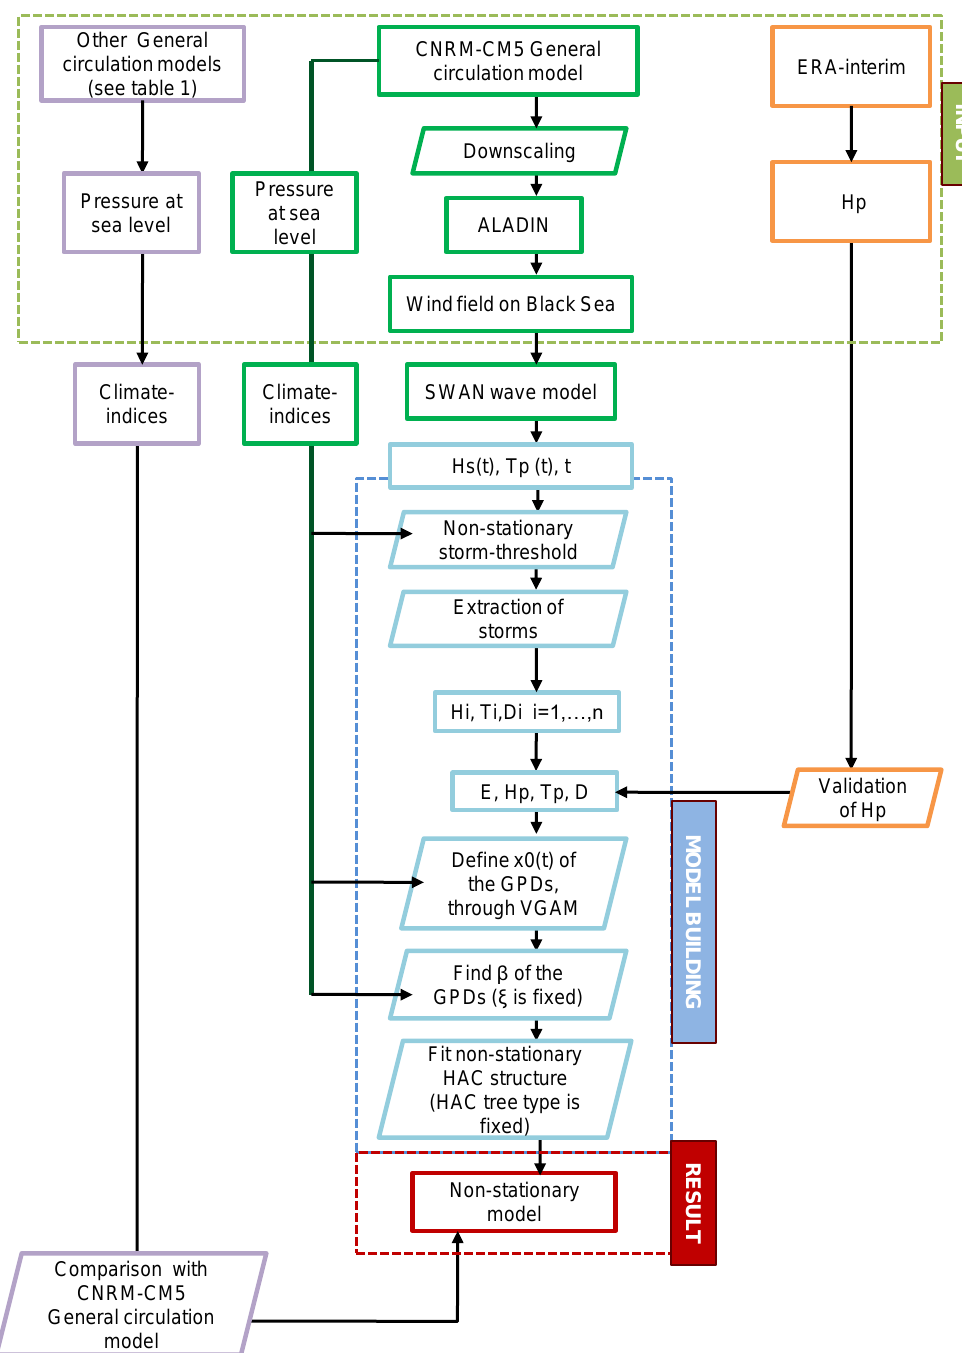
Figure 2. Flow-chart of the different steps in the proposed hybrid methodology. This methodology is analogous for each climate change scenario (Representative Concentration Pathways, RCP, 4.5 and 8.5). CNRM-CM5 is the General (Atmospheric) Circulation Model used to build the statistical model. ERA-interim is the reanalysis used to validate the statistical model. Each variable is fit by a generalized Pareto distribution (GPD) function and their joint probability structure is characterized by a series of hierarchical Archimedean copulas (HAC). Rectangles are the results, rhombuses are the methods. Different colors are only intended to separate different stages of the process. Elements inside the “input” box have been obtained from external sources. The side analyses are not included in the graph, for the sake of